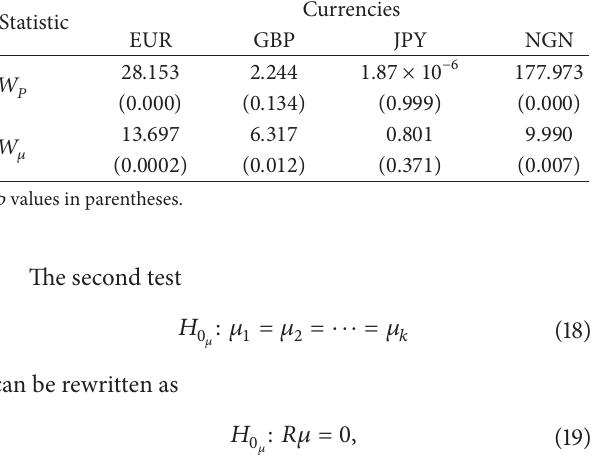
Table 3: Hypotheses testing: random walk versus long swings. Statistic